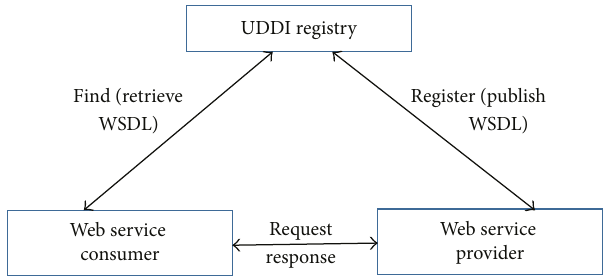
Figure 1: Web service